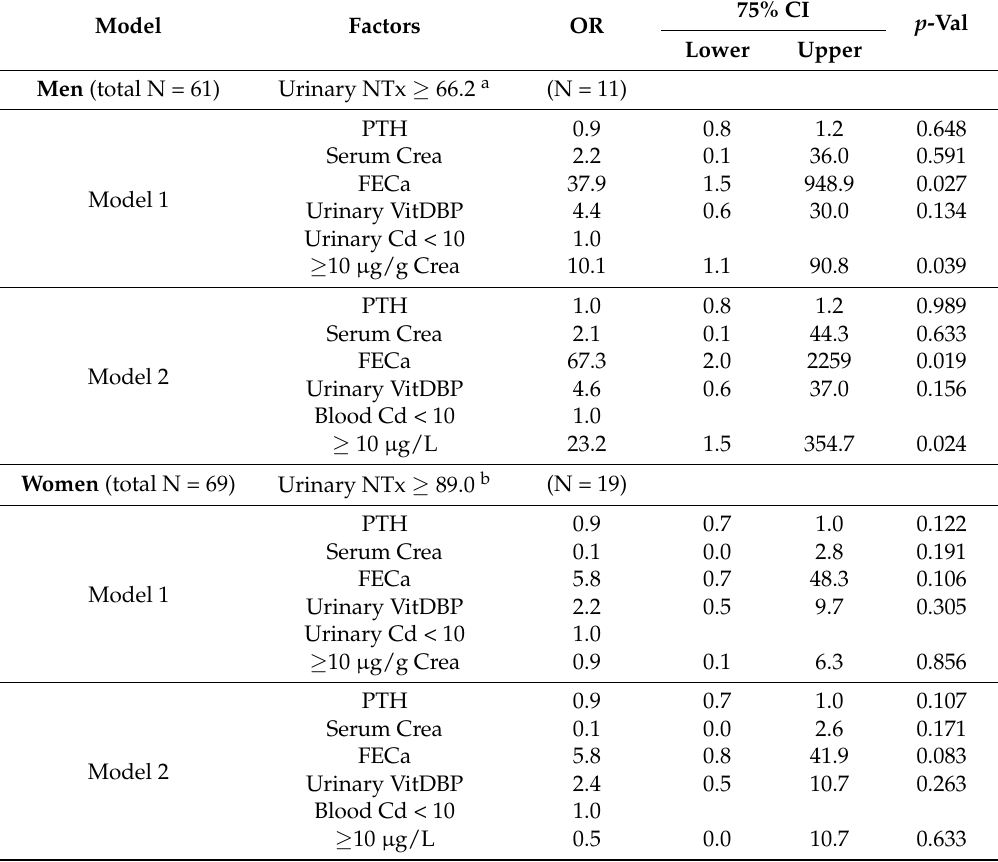
Table 5. Risk factors for bone metabolic disorders, indicated by urinary NTx, analyzed using logistic regression